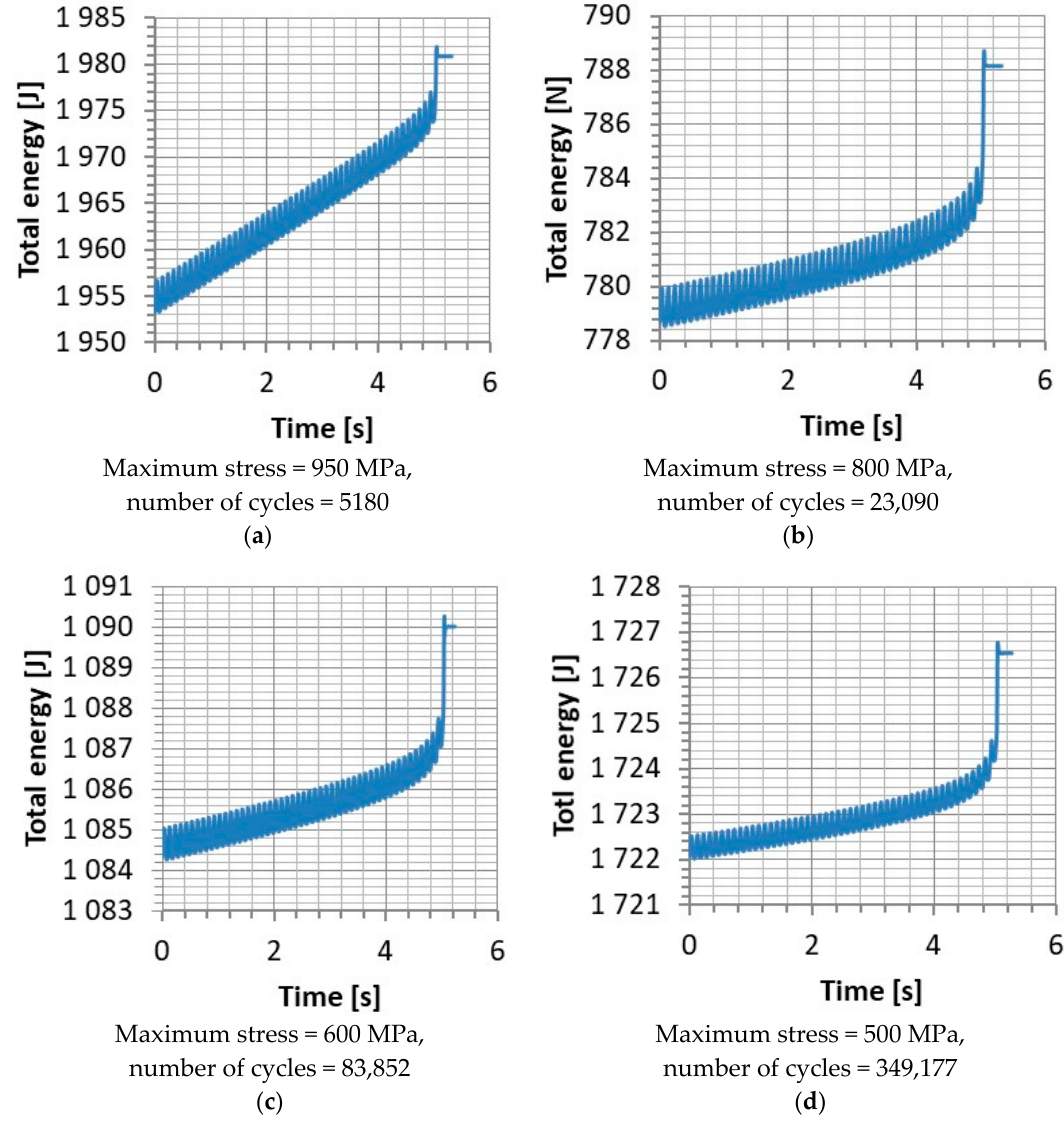
Figure 13. Total energy versus time before fracture of the weld under the following values of maximum stress: ( a ) 950 MPa, ( b ) 800 MPa, ( c ) 600 MPa, ( d ) 500